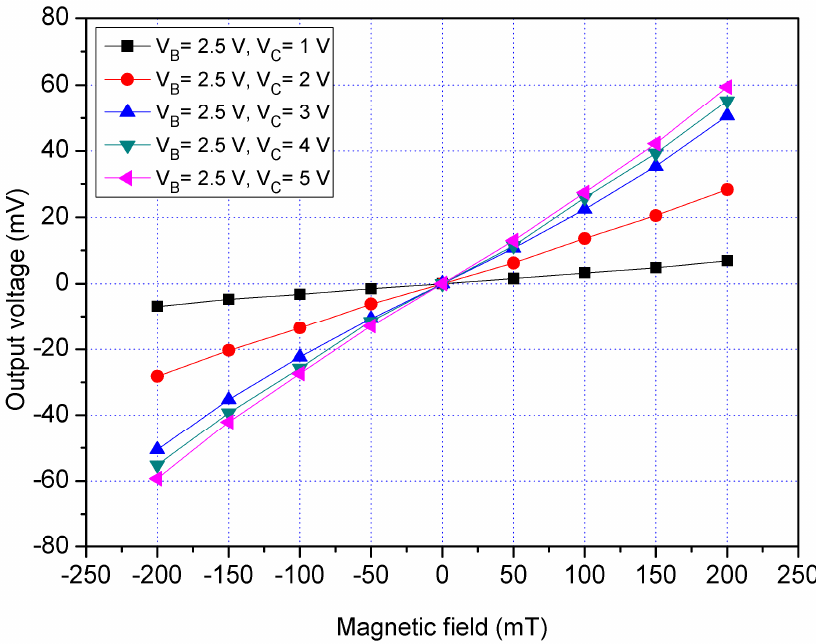
Figure 14. Measured Vo for the x/y-MSE without bias of the additional collectors in the y-direction